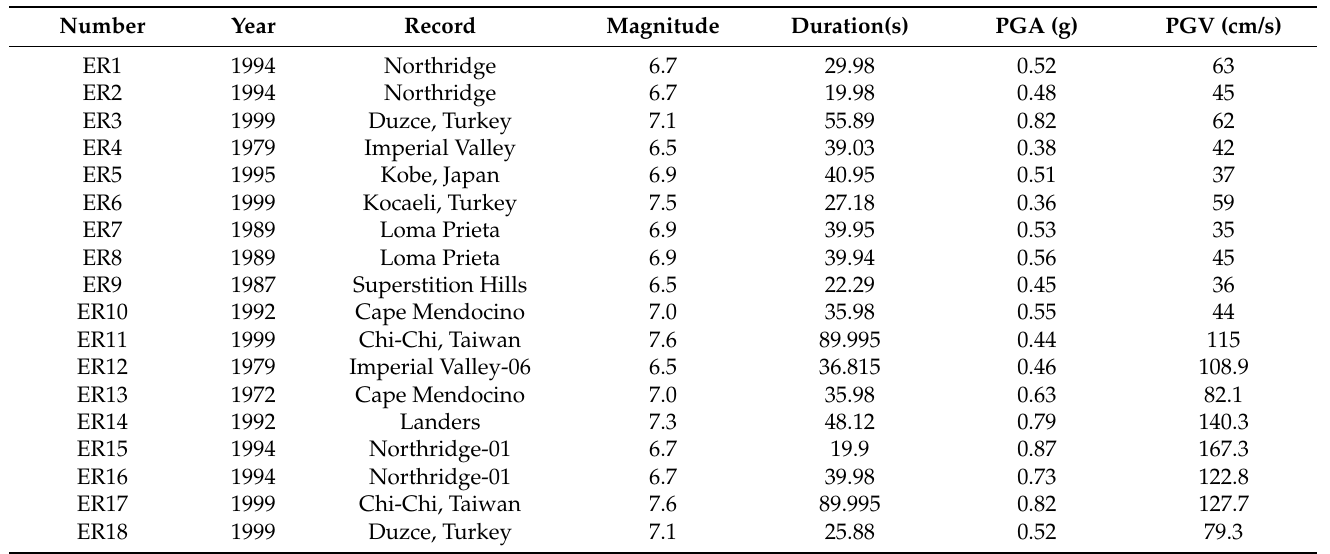
Table 2. Earthquake